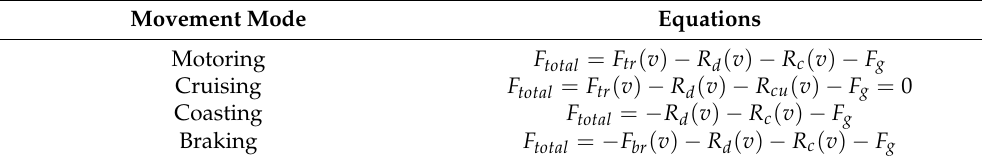
Table 1. Train movement